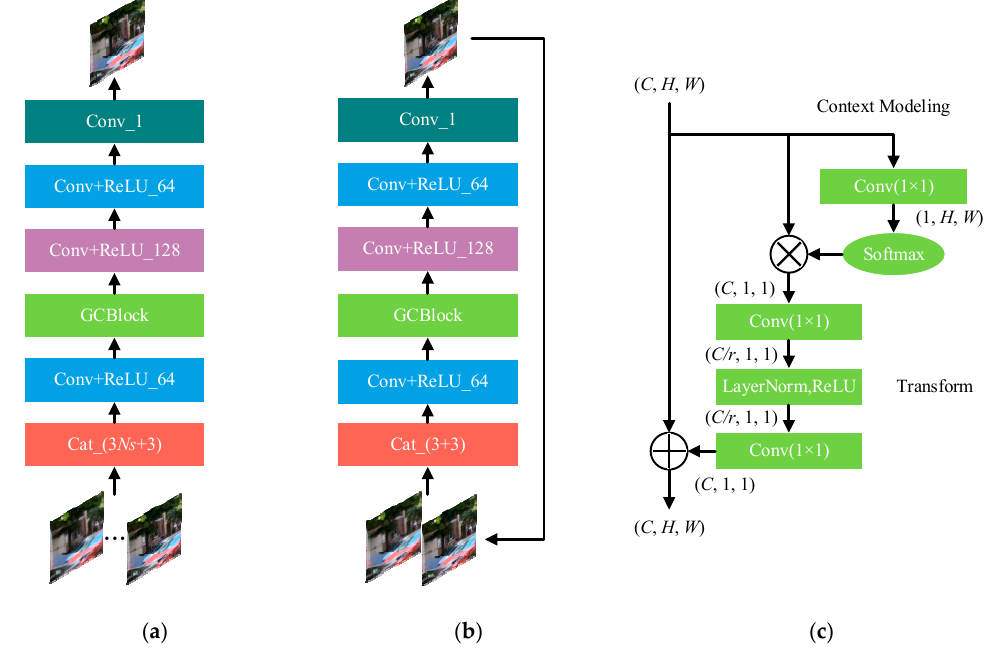
Figure 3. The architecture of the sub-network models. ( a – c ): GIFNet, GIRNet, and GCBlock, respectively. Here, ( C , H , W ) means a feature map with the number C of channels, height H , and width W ; r denotes channel compression ratio; ⊗ represent matrix multiplication; ⊕ means broadcast element-wise addition.